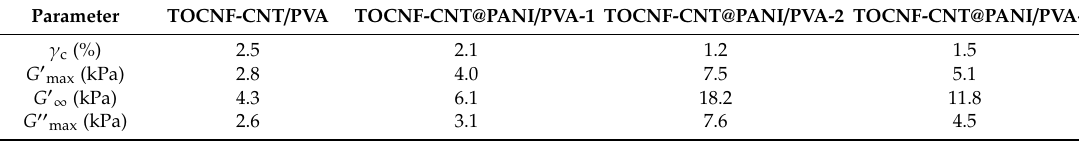
Table 2. Rheological characteristics from viscoelasticity